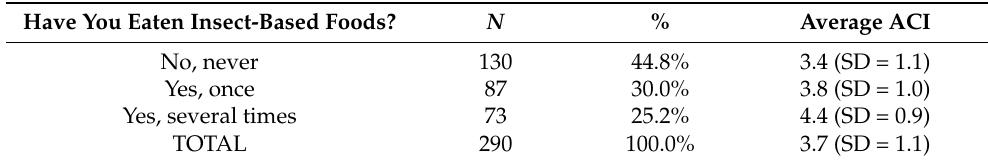
Table 3. Previous experiences with insect food consumption and respective ACI